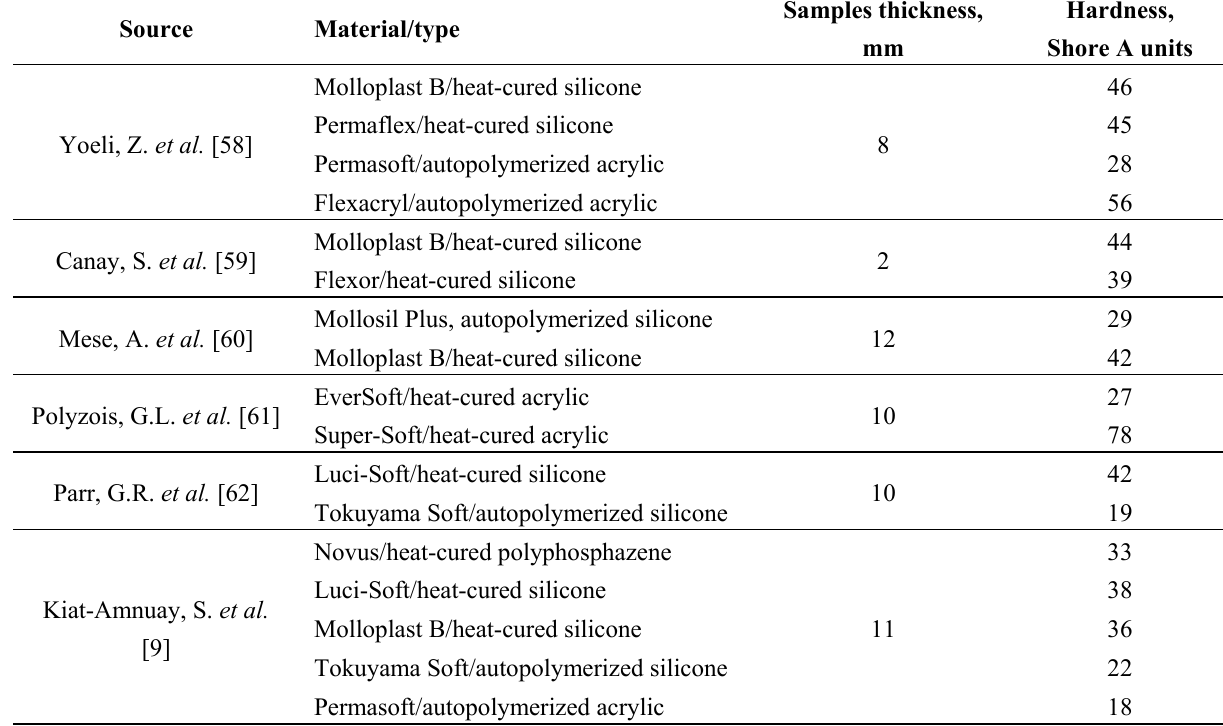
Table 1. The initial hardness values of the long-term soft denture linings (LTSDLs), measured for samples with different thicknesses at the beginning of different